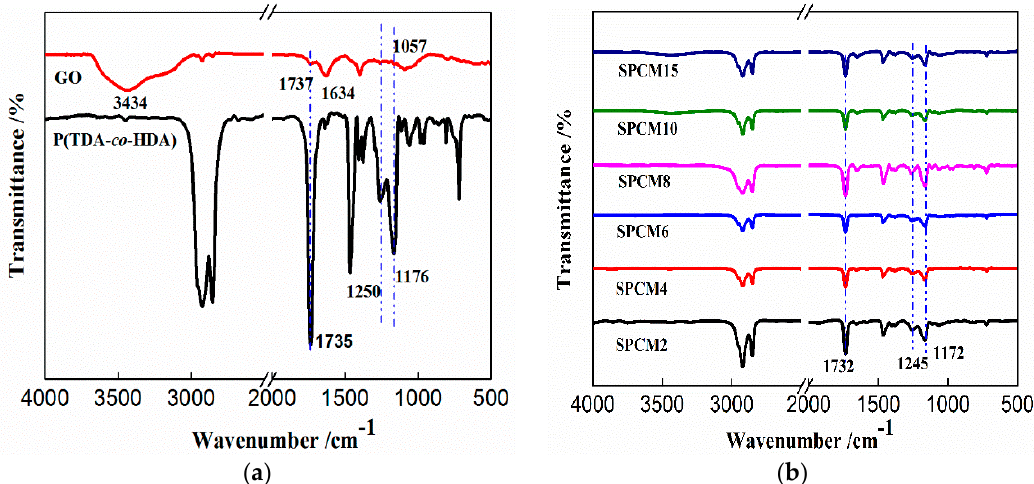
Figure 1. Fourier-transform infrared (FTIR) spectra of ( a ) graphene oxide (GO) and poly(tetradecyl acrylate- co -hexadecyl acrylate) (P(TDA- co -HDA)), and ( b ) the shape-stabilized phase change materials (SPCMs).